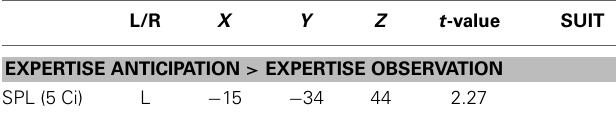
Table 2 | Brain areas showing stronger activation as a function of the number of correct responses in tennis and volleyball serve anticipation conditions when contrasting the anticipation of serves in both sports with the ball bouncing conditions in both sports in all